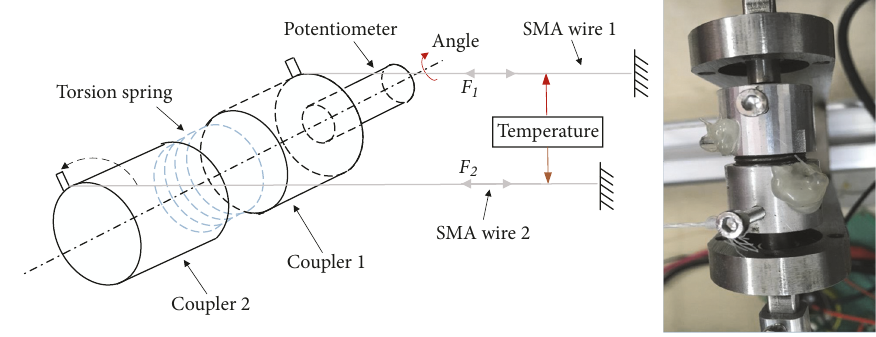
Figure 1: Schematic of the SMA compliant actuating system.